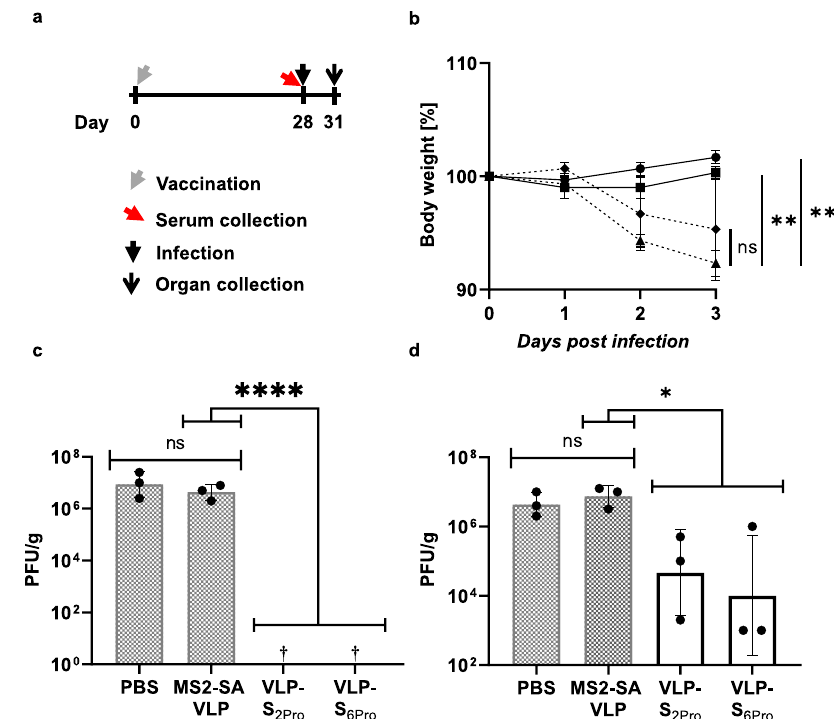
Fig. 4 Protective ef fi cacy of VLP-S. a Schedule for vaccination of hamsters, serum collection, infection, and organ collection. b Body weight of hamsters immunized with a single dose of either VLP-S 6Pro (solid line with circles), VLP-S 2Pro (solid line with squares), MS2-SA VLP (dashed line with triangles), or PBS (dashed line with diamonds) after SARS-CoV-2 infection (mean±SD, n = 3 hamsters). ns: not statistically signi fi cant, ** p <0.01, determined by a one- way analysis of variance (ANOVA) and Dunnett post-hoc multiple comparison between groups ( α = 0.1). Assumptions of the normality of residuals and homogeneity of variance were validated by the D ’ Agostino-Pearson test and the Brown – Forsythe test, respectively. c Viral titer in the lungs of hamsters immunized with either PBS, MS2-SA VLP, VLP-S 2Pro or VLP-S 6Pro three days after SARS-CoV-2 infection (geometric mean with geometric SD, n = 3 hamsters). †— No infectious virus was detected in the lungs of hamsters immunized with VLP-S fi 2Pro or VLP-S 6Pro (detection limit 10 PFU/g). ns: not statistically signi